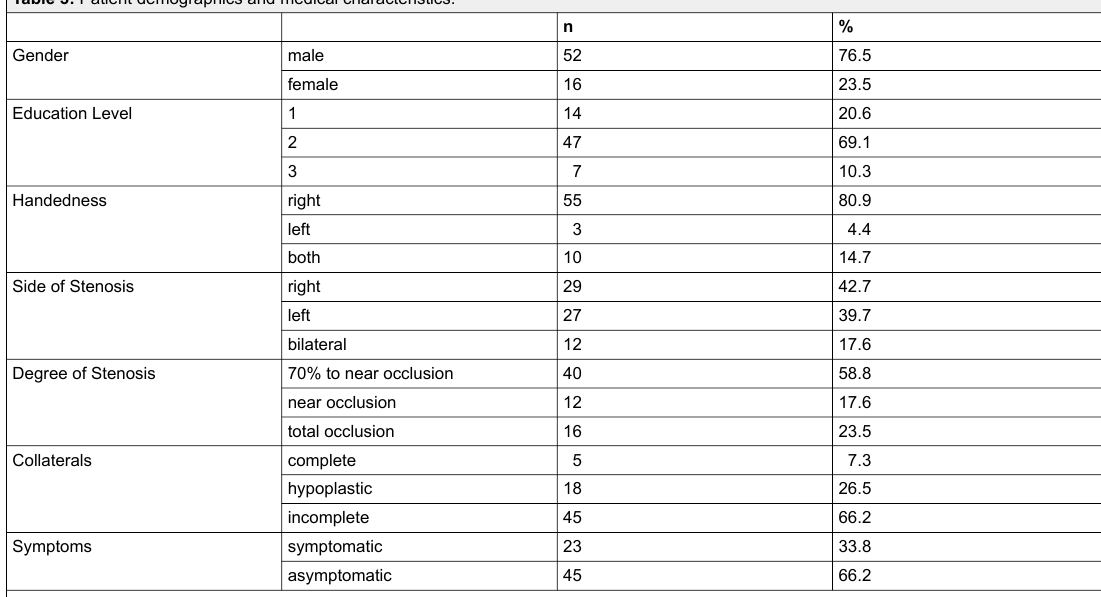
Table 3: Patient demographics and medical